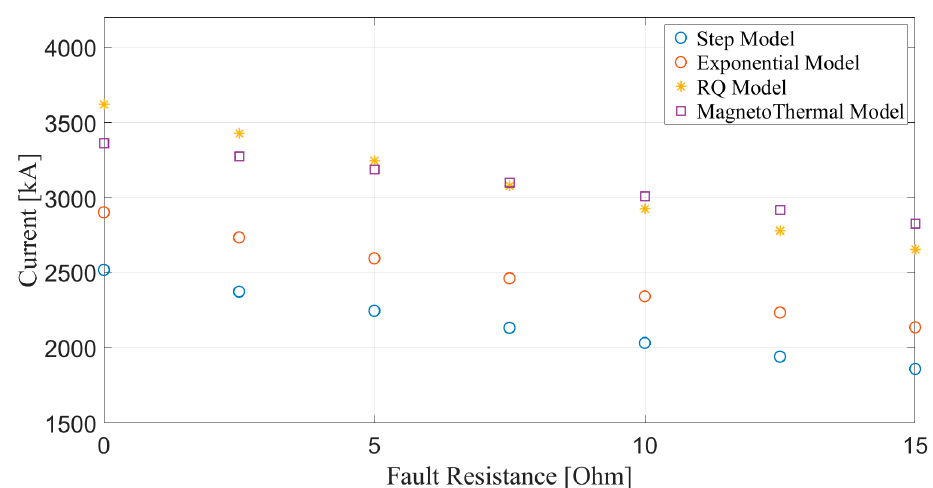
Figure 14. Peak current comparison for different fault resistance values and 300 A critical current.